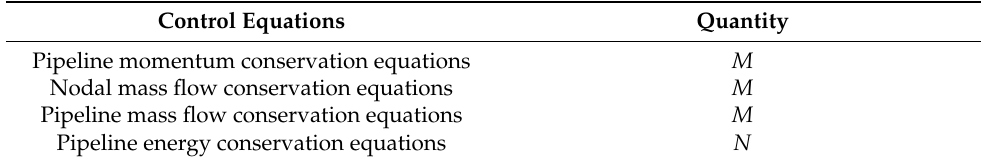
Table 2. Control equations of an N -node and M -branch steam heating